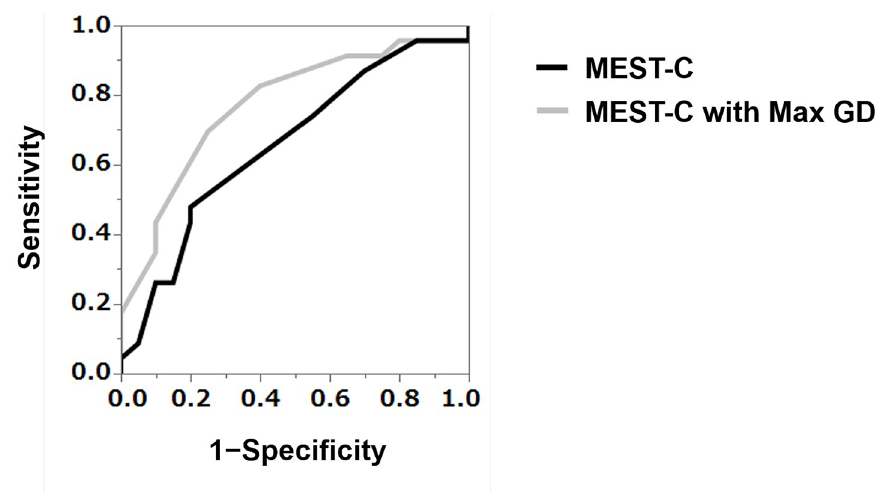
Fig 2. Receiver operating characteristic curves and the C-statistic (area under the curve) for the models predicting the risk of a � 50% eGFR or ESRD using the Oxford (MEST-C) score with or without a maximal glomerular